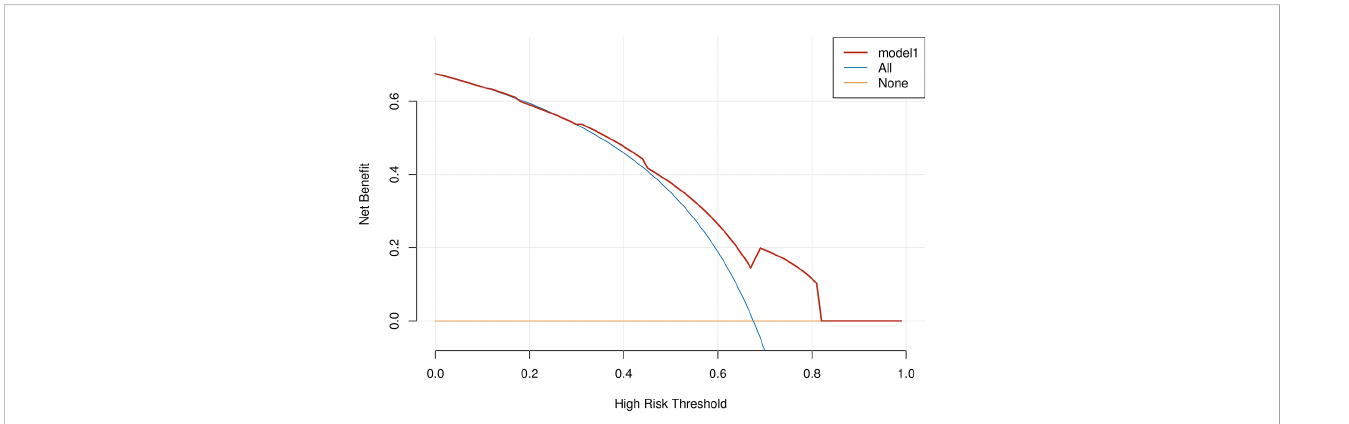
FIGURE 6 A decision curve analysis (DCA) was performed on the nomogram of the model. The solid black line assumes that all patients are LNM positive or negative, respectively. The dashed lines represent the net payoff of the nomogram at different threshold